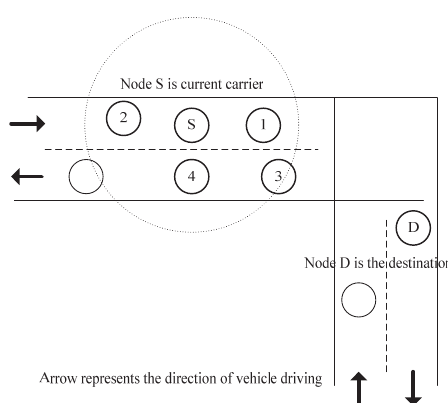
Figure 5. An example of the straightway